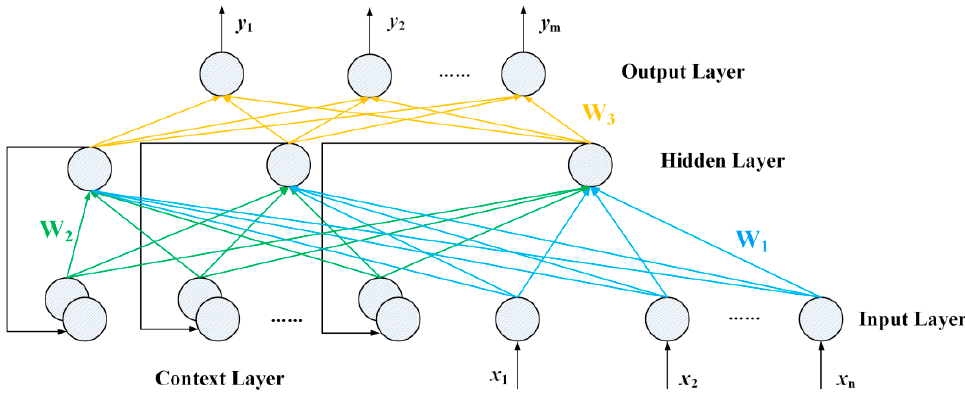
Figure 7. The structure of the ELMAN surrogate model [33].